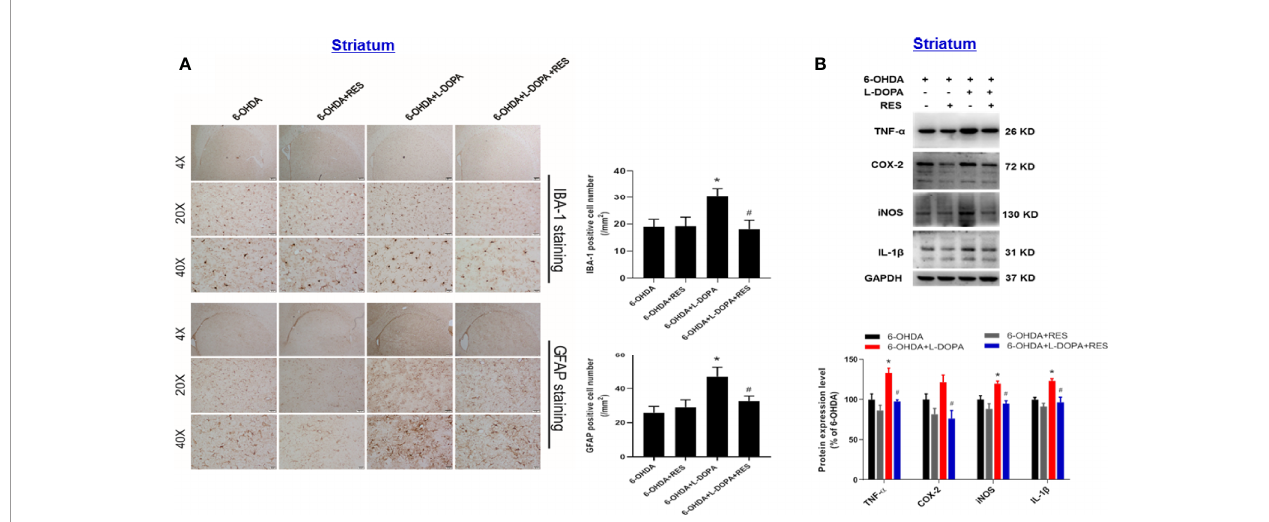
FIGURE 6 | Effects of RES on in fl ammatory responses in the striatum of rats with LID. Rat striatum tissue were sectioned and immunostained with anti-GFAP and IBA-1 antibodies 42 days after L-DOPA administration. The number analysis of IBA-1-positive microglia and GFAP-positive astroglia in the striatum from 3 evenly spaced brain sections of each rat was determined (A) . The protein levels of pro-in fl ammatory mediators, such as TNF- a , iNOS, COX-2 and IL-1 b , in the striatum 42 days after L-DOPA administration were detected by western blot assay (B) . The densitometry values of TNF- a , iNOS, COX-2 and IL-1 b were detected and normalized to GAPDH of the same group. Then, data were normalized and calculated as a percentage of each respective 6-OHDA group. Data were expressed as mean ± SEM from 5 rats. * P < 0.05 compared with 6-OHDA group; # P < 0.05 compared with 6-OHDA+L-DOPA group.